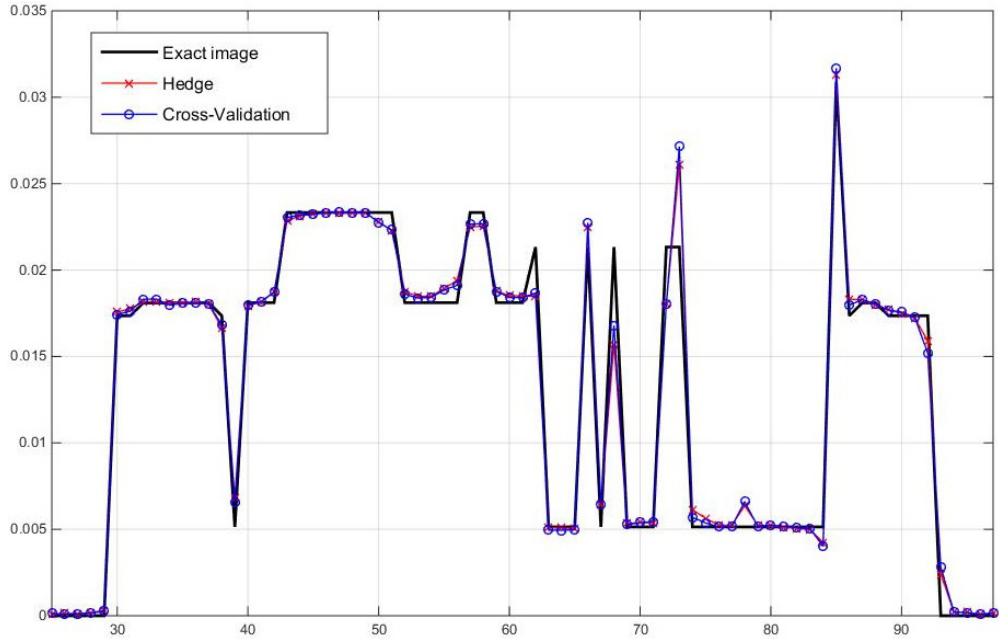
Figure 7. One dimensional profile plots along pixel numbers 25 to 97 of the reconstructed images from two hyper-parameter selection methods along one arbitrary row of the images, in comparison with the exact